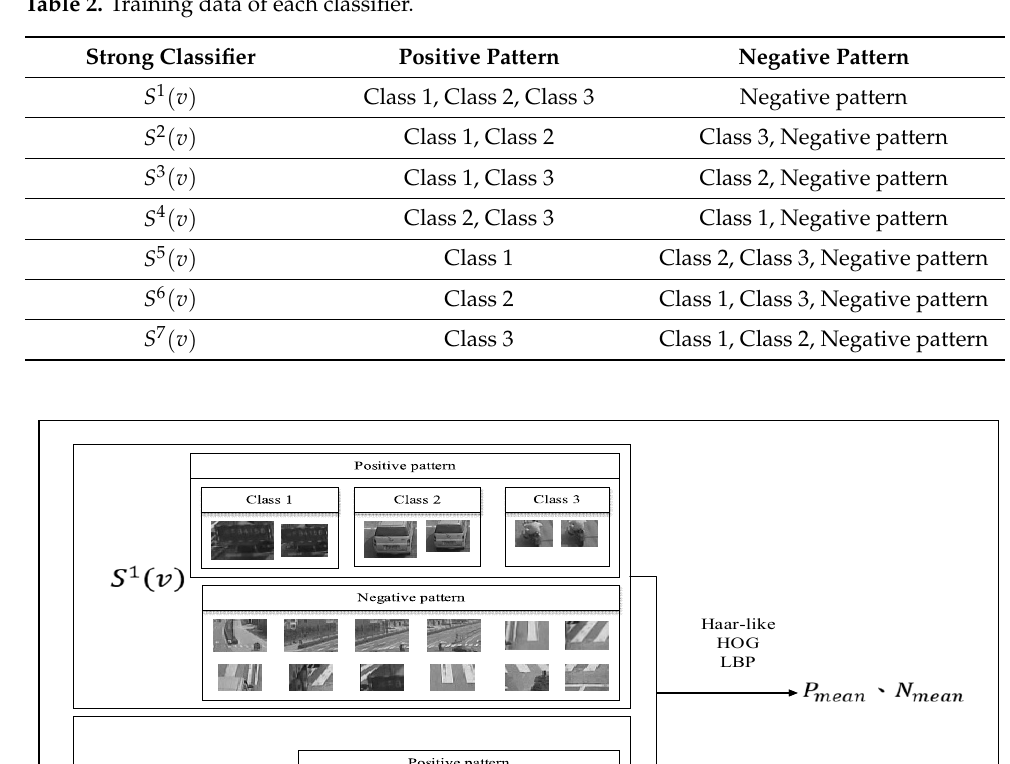
Table 2. Training data of each classifier.